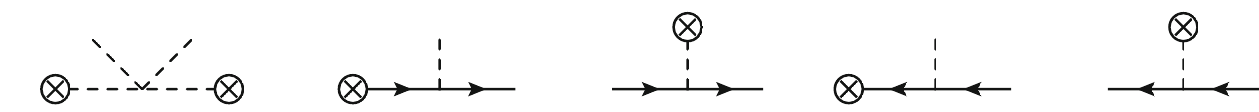
Fig. 17 Various vertices containing one internal graviton line and one internal fermion leg. Here the dashed line is the scalar, solid line with arrow is fermion, while the double line depicts graviton. The lines ending with a circle containing a cross are external legs